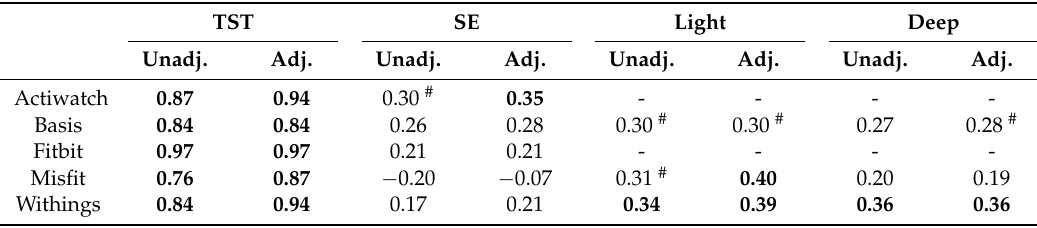
Table 5. Correlations of measures (r) from each device with PSG. Bold indicates significance (p < 0.05) and # indicates marginal significance (p <